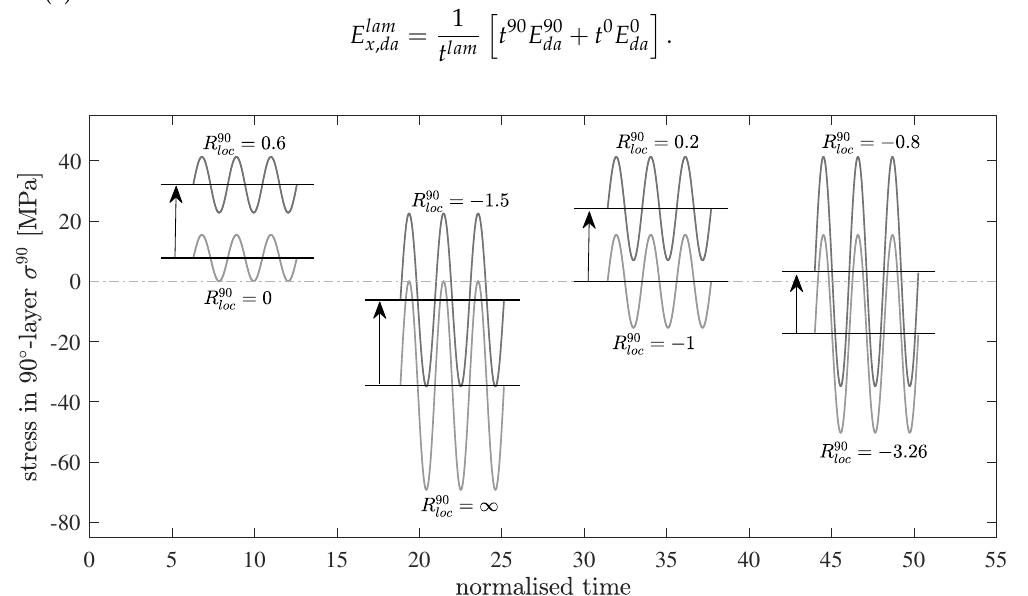
Figure 14. Schematic representation of the mean stress shift in the embedded 90 ◦ -layer caused by the manufacturing-induced residual stresses for different local stress ratios R 90